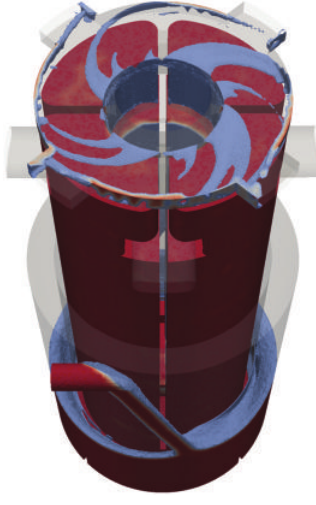
Figure 11: Simulation of free surface flow (water, air) in for a coupled annular mixer, rotor centrifugal contactor model taken from Wardle, [145]. The spiraling flow of liquid over the upper weir can be seen; rotor rotation is in the counter-clockwise